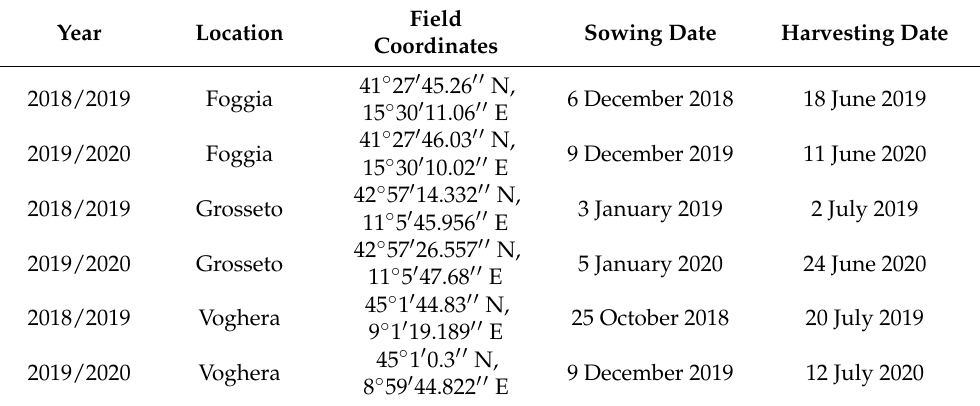
Table 2. Geographical coordinates and sowing and harvesting dates related to all locations and agronomic